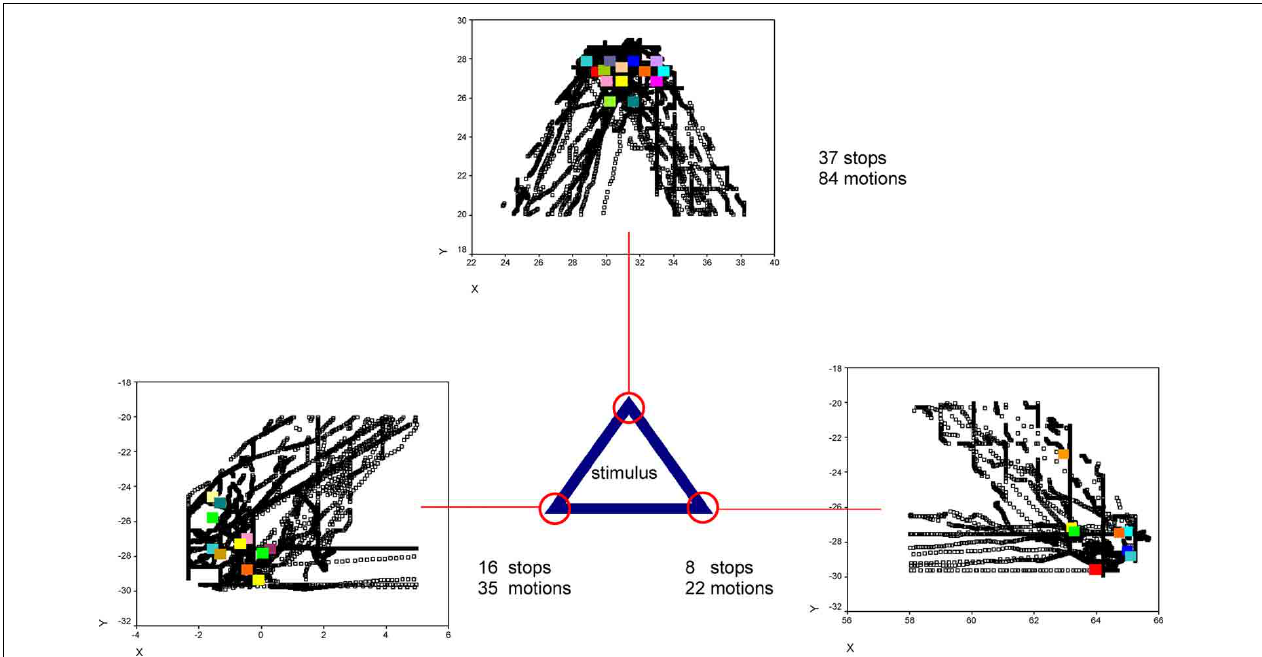
FIGURE 6 | Exemplary XY-positions of one participant’s explorative stops (color points) and motions (black points) at the corners of one virtual stimulus (triangle) are shown. Under/ beside the diagrams the number of explorative stops and the number of motions is